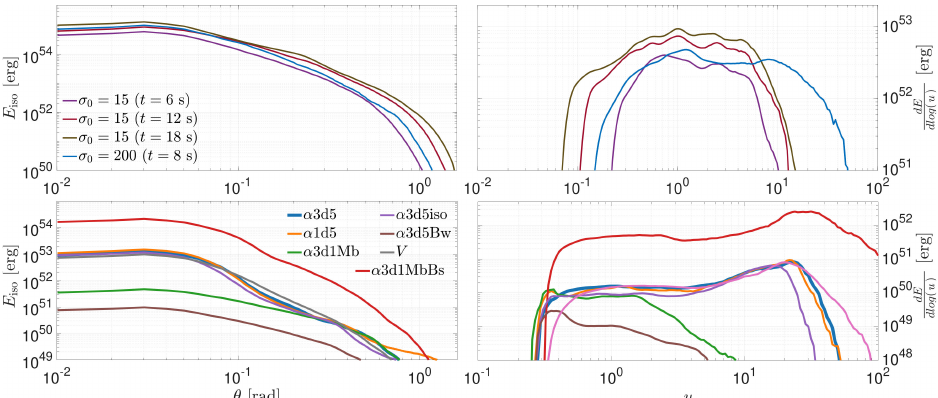
Figure 4. Jet structures resulting from GRMHD simulations representing collapsars (upper panels, adapted from [151]) and binary neutron star merger remnants (lower panel, adapted from [152]). Left-hand panels show the isotropic-equivalent energy E iso = 4 π d E /d Ω from a late snapshot of the simulations (significantly later than the jet breakout), while right-hand panels show the distribution of energy in the four-velocity modulus u = Γ β space. Different colors refer to different initial conditions, as detailed in